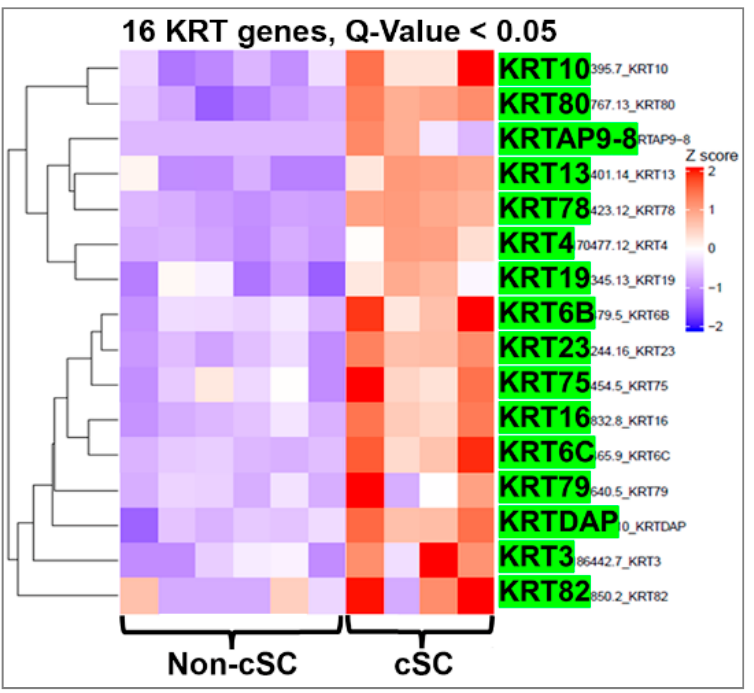
Figure 6. Heatmap clustering of keratin genes in PCa stem-like cells (cSCs) and the non-stem cells in tumor spheroids from PCa specimens. RNA-seq followed by heatmap clustering analysis shows that in addition to normal stem cell-enriched keratins ( KRT13, 23, 80, 78, 4 ), KRT10, 19, 6C, 75, 16, 79, 3, and 82 also were enriched in cancer stem-like cells relative to expression levels in the non-cSC population. Q -value < 0.05.